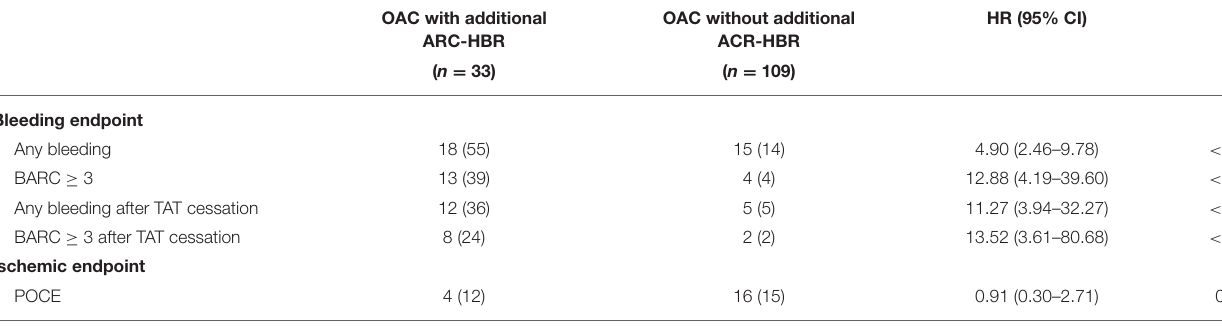
TABLE 4 | Clinical outcome at 2-year follow-up according to major ARC-HBR criteria.